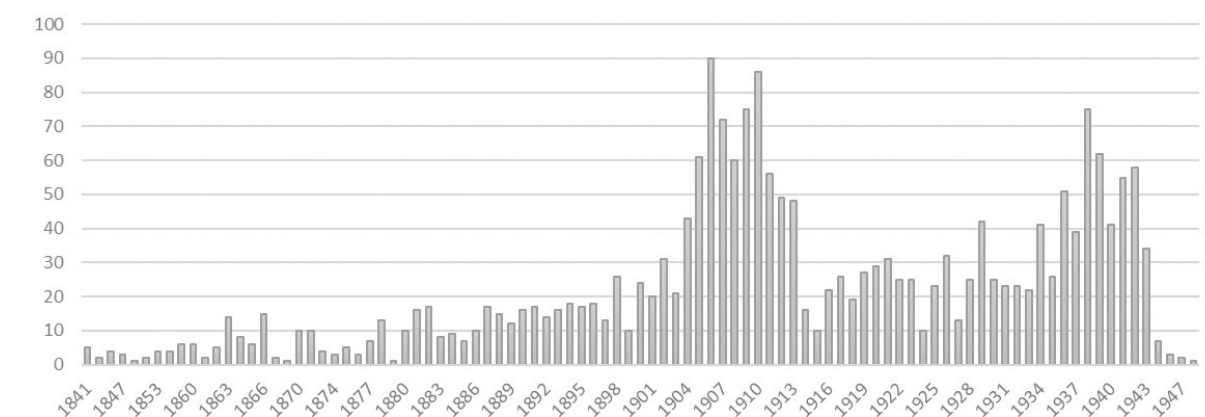
Figure 1 Statistical distribution of Chinese modern factories during the period 1840–1948 (Source: Subin